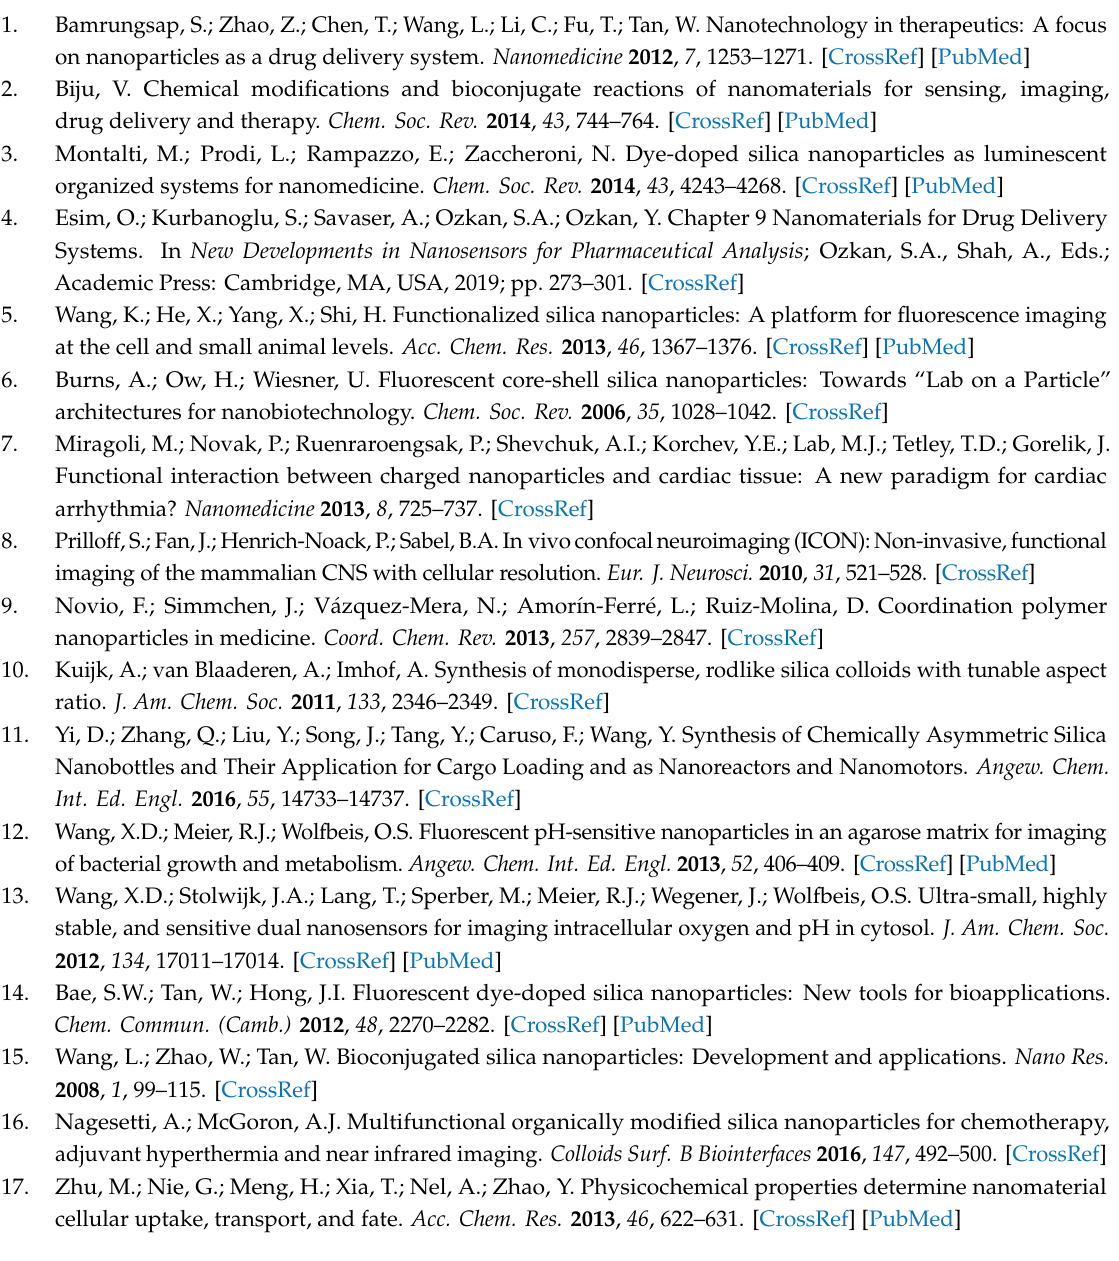
Figure S1: Reagents and conditions, Figure S2. Dynamic light scattering (DLS) data, Figure S3: SEM images of preparation CSP-SN@OH and their response emission spectra, Figure S4: The slopes of the Lippert plots, Figure S5: SEM images of preparation CSP-SN@OH / NH2, Figure S6: The cytotoxicity evaluation of CSP-SN@OH / NH2, Figure S7: The performance of CSP-SN@OH / NH2 for long-term